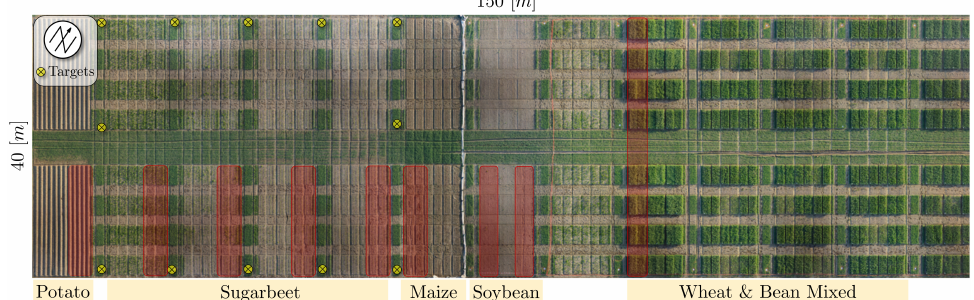
Figure 3. Field experiment at campus Klein Altendorf near Bonn, Germany. The field contains plots of potato, sugar beet, maize, soybean, and a mixture of wheat and beans. The plots and rows observed by the system within the vegetation period of 2021 are highlighted by red boxes. Landmark targets that we use for later georeferencing precision evaluation are drawn as yellow